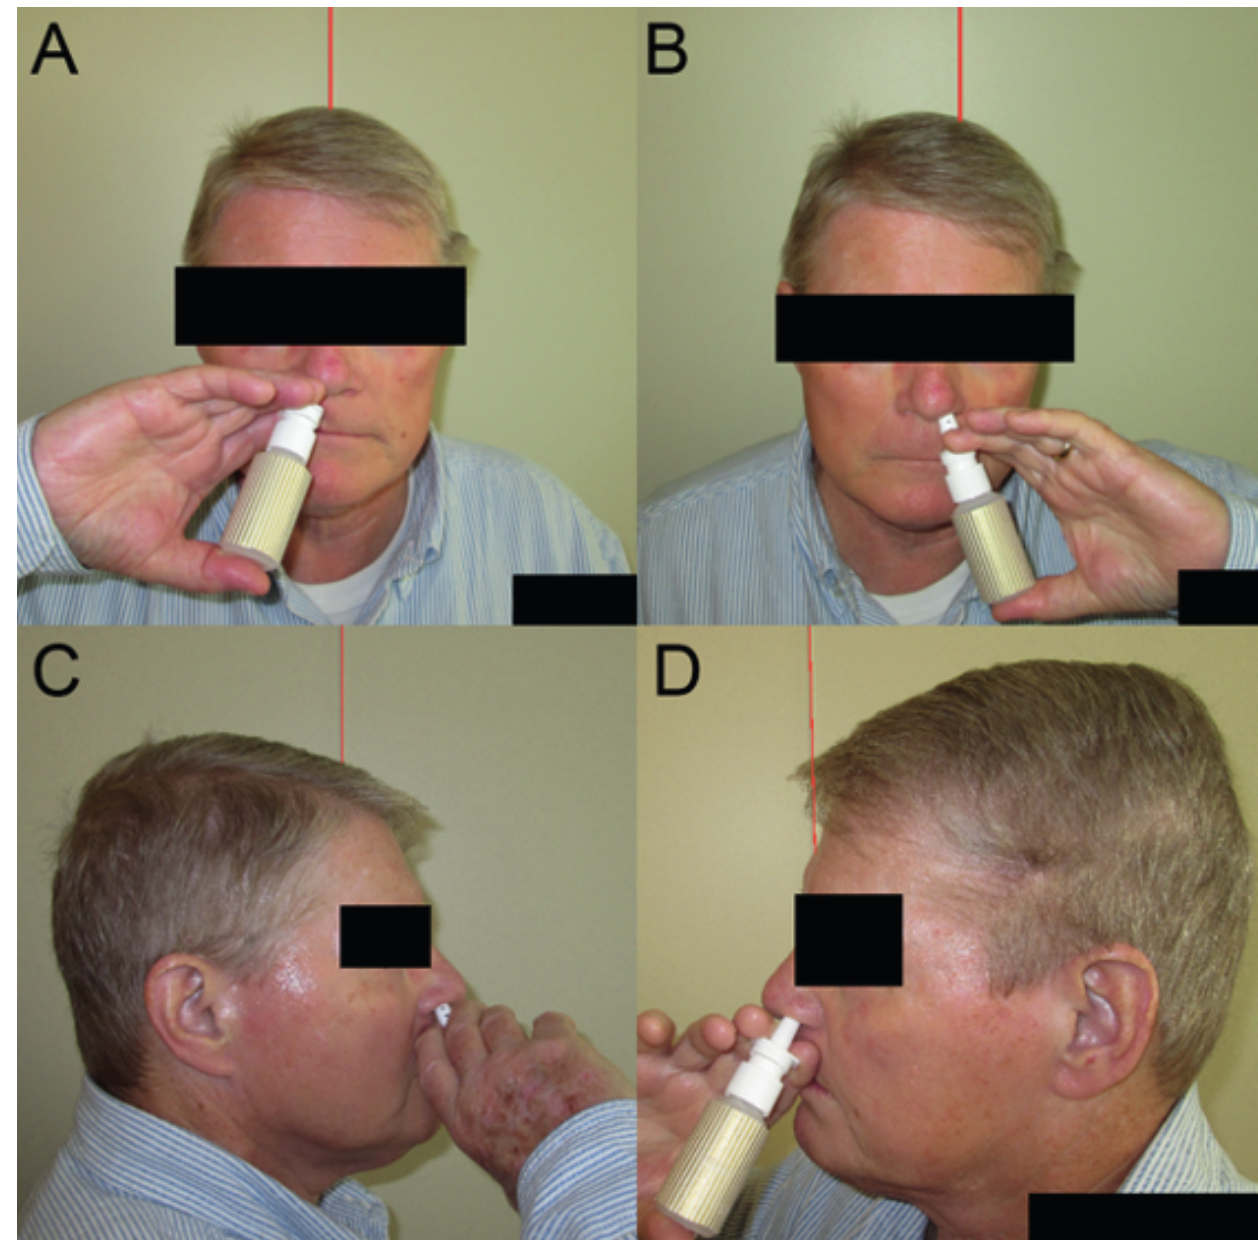
Figure 1. Photo documentation of a patient administering nasal spray into his right and left naris. Frontal picture of patient administering intranasal spray into the (A) right and (B) left nares. Profile picture of patient administering spray into his (C) right and (D) left